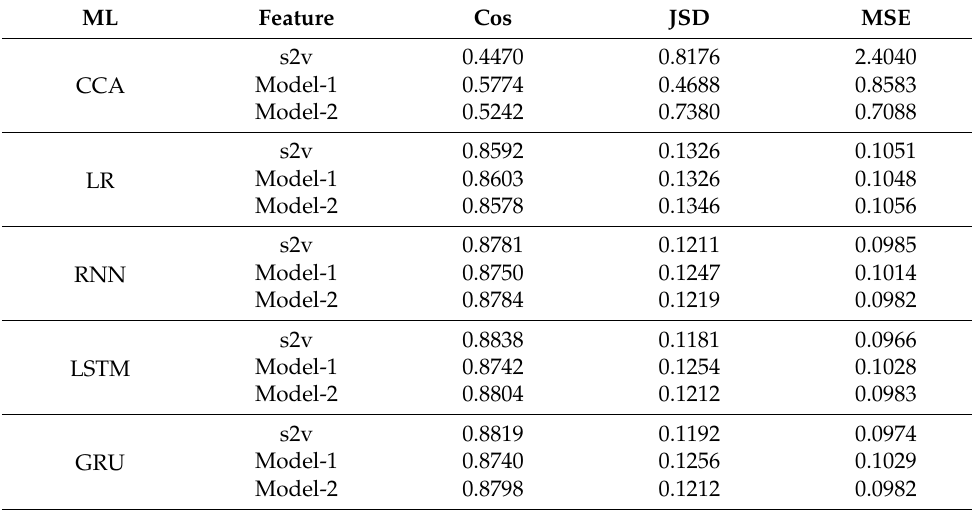
Table 18. Comparison of cosine, JSD, and MSE (DIT).